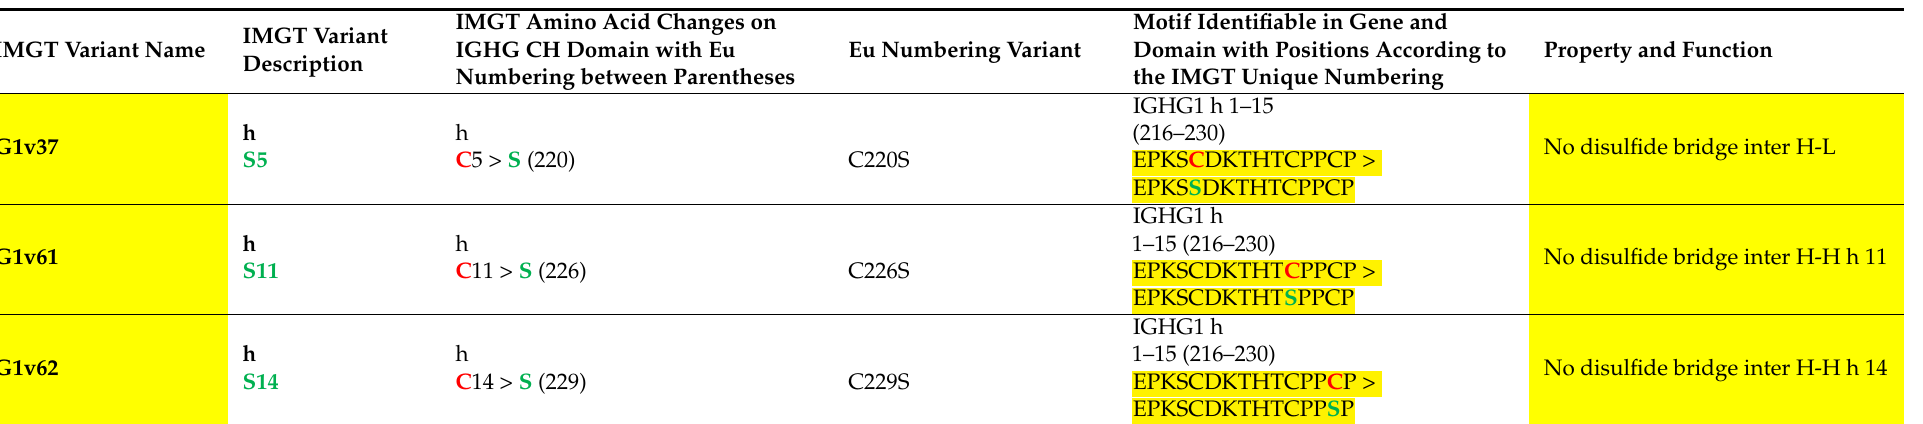
Table 19. IMGT nomenclature, Eu positions and IMGT motif of engineered Fc variants involved in the suppression of inter H-L and/or inter H-H disulfide bridges (Structure